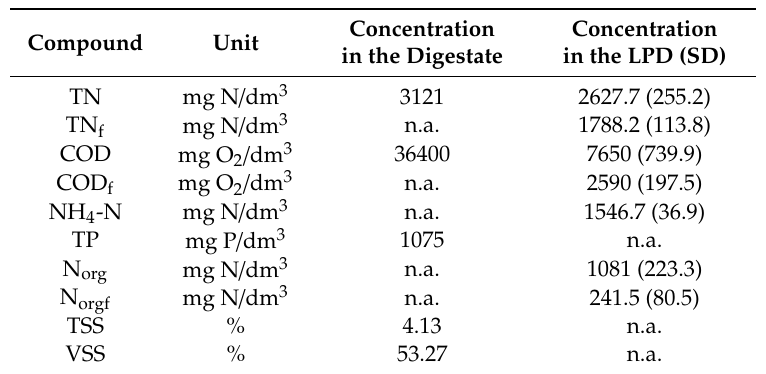
Table 2. Characteristics of the digestate and